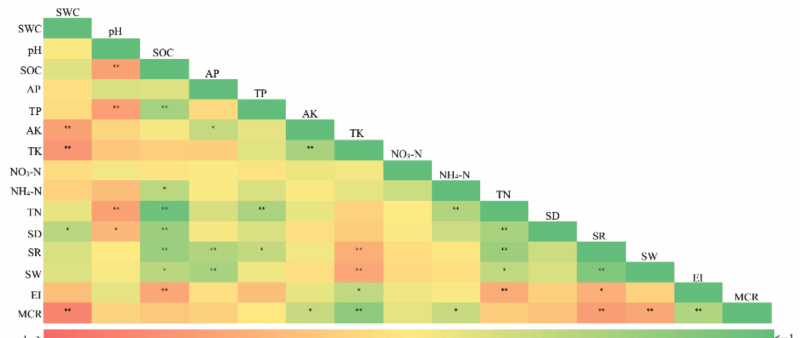
Figure 5. Pearson’s correlations between arbuscular mycorrhizal community characteristics and soil